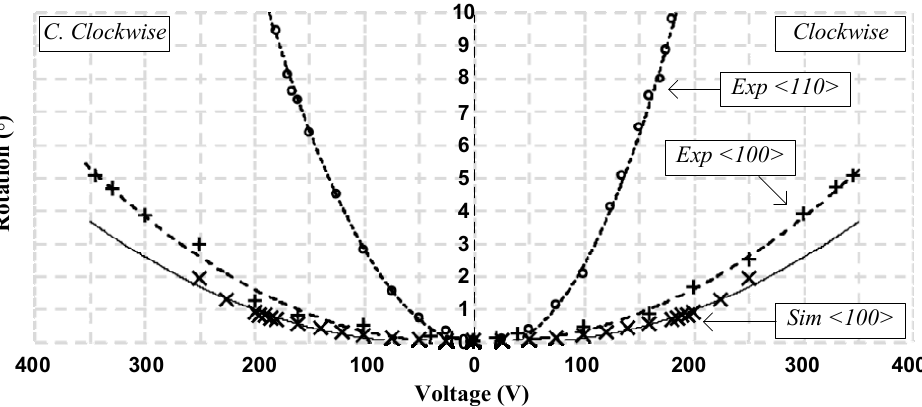
Figure 9. Platform angular displacement for left and right actuation of the third design with fitting curves showing more than ±5° both sides for <100> anchor orientation and ±9.5° for <110> anchor orientation where the “×” data points represent simulated data, the solid line is a fit to the simulated data, the “+” data points represent experimental measurements on the <100> fabrication plane, the “o” data points represent experimental measurements on the <110> fabrication plane, and the dotted lines are a fit to the experimental measurements.